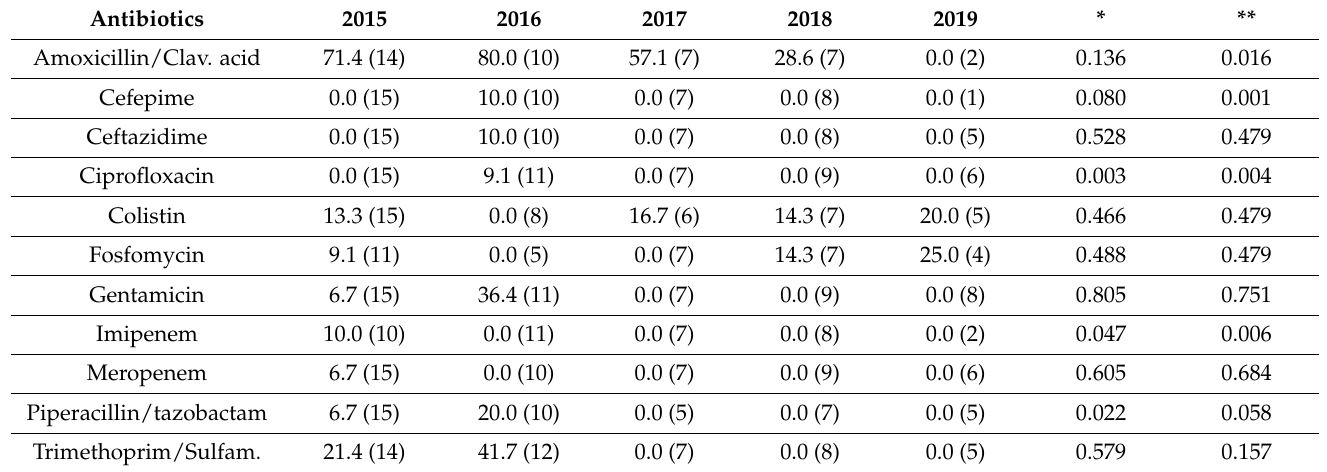
Table 6. Resistance rates of Gram-negative species isolated from ocular samples by year in %( n